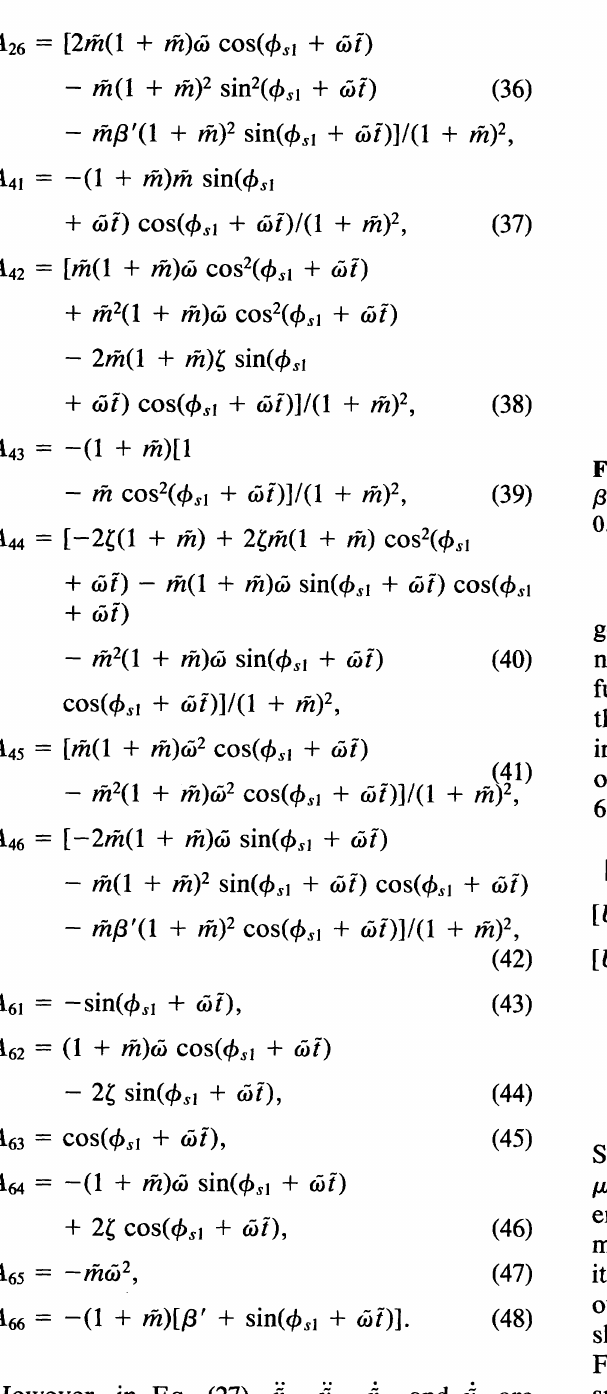
FIGURE 3 Characteristic multipliers (w = 1.5 and f3' = 0.01 case). Characteristic multipliers: -0.4129 ± 0.8925i, 0.7617 ± 0.6116i, and -0.4925 ±